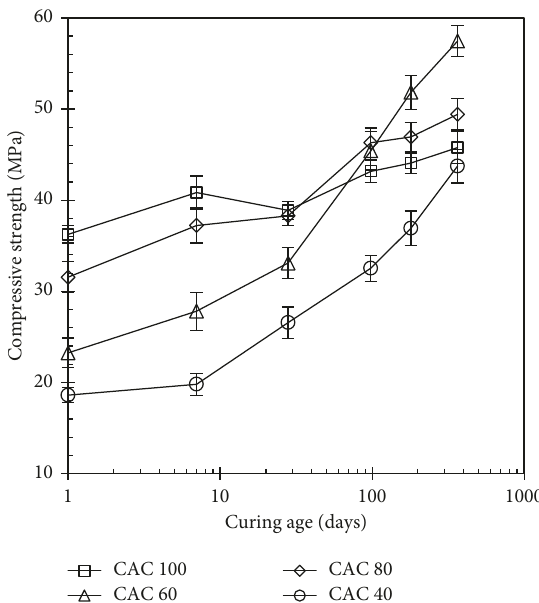
Figure 6: Compressive strength for mortar of CAC-GGBS mixtures with time. The error bars represent the standard deviation of measurements in six separate specimens for each mix ( n �